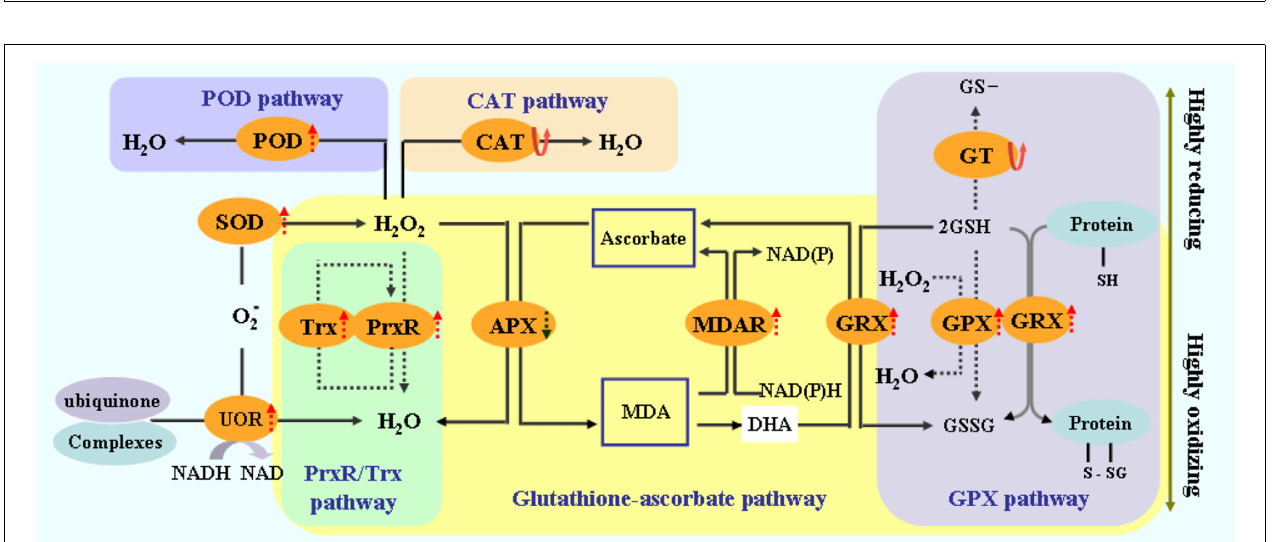
( Figure 7D ). Among these proteins, seven (G-box-binding fac- tor, mitogen-activated protein kinase 4, phosphofructokinase, glycerol kinase, phosphoglycerate kinase, nucleotide binding pro- tein, and ACC oxidase) were related to the signal transduction